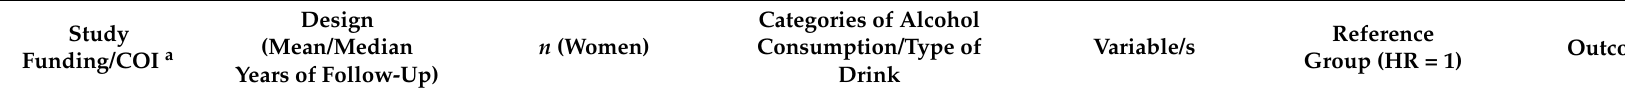
Table 5. Summary of main mortality